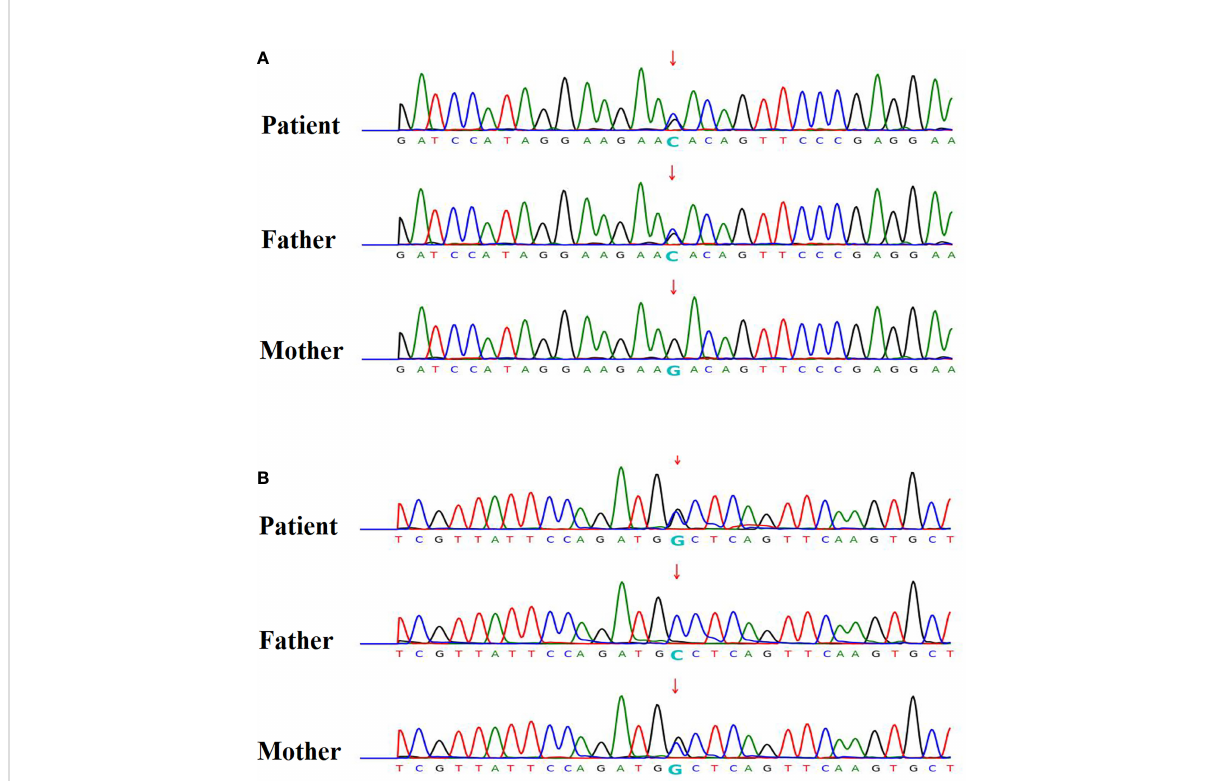
FIGURE 1 Patient 12 had hypocalcemic seizures which started to appear 8 days after birth in one newborn. The patient ’ s calcium level was 6.8 mg/dL (ion calcium, 0.71 mg/dL). The patient was diagnosed with Alström Syndrome with WES and was found to carry a compound heterozygous ALMS1 (NM_015120.4) (A) c.10323G>C (p.K3441N) / (B) c.10079C>G (p.A3360G) mutation inherited from one each parent respectively. According to her phenotype, a Alström syndrome was